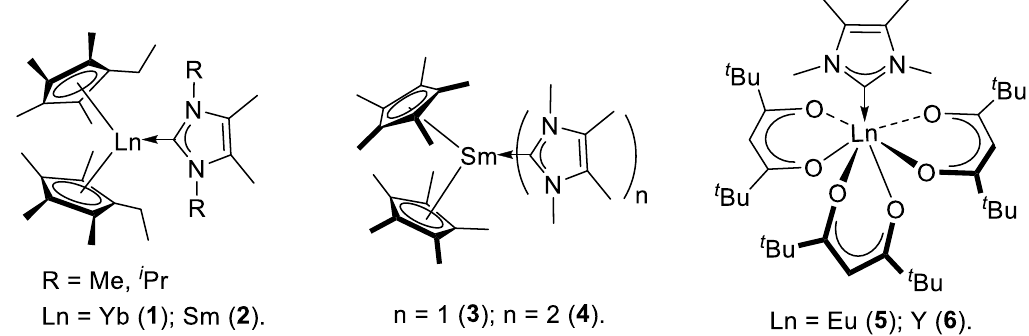
Figure 1. Ln complexes with N-heterocyclic carbene (NHC) ligands.